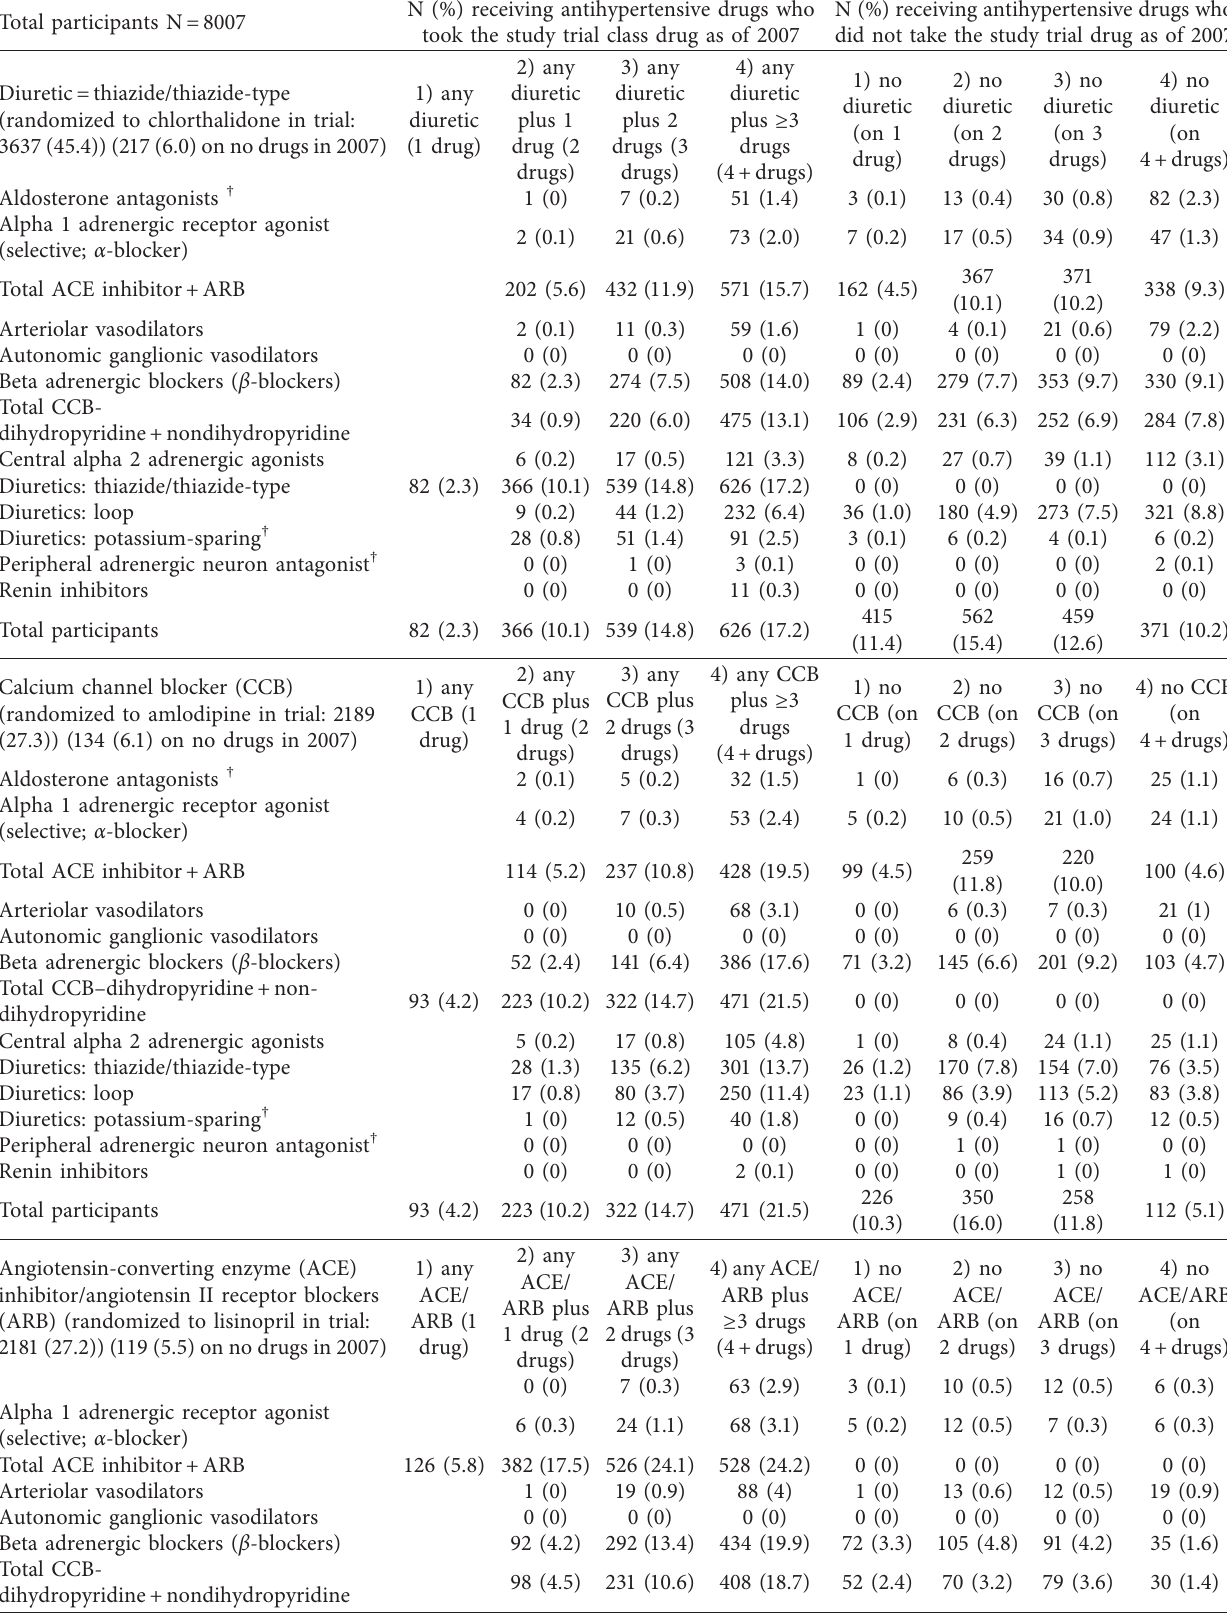
Table 2: Patterns of antihypertensive drug utilization from Medicare Part-D drug coverage in 2007, by trial arm. Total participants N �